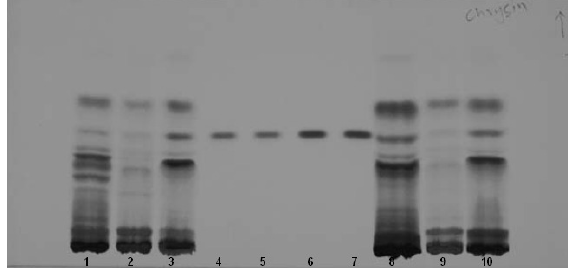
Figure 2. Chromatographic plate of standard chrysin with Oroxylum indicum vent at 254 nm BD * * Ethanolic extract of Oroxylum indicum vent (1=WG leaf; 2= WG stem; 3= WG root; 4,5= Ch 2 µL; 6,7=C h 5 µL; 8= UP leaf; 9= UP stem; 10= UP root) WG: Western Ghats; UP: Uttar Pradesh; Ch: